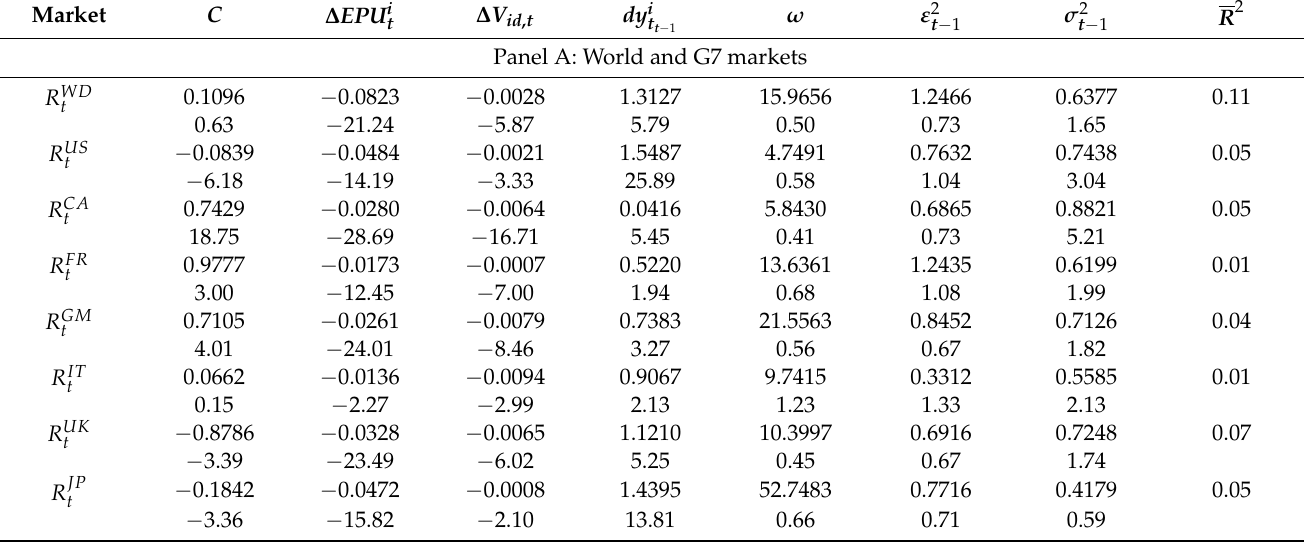
Table 4. Estimates of the global stock returns in response to change in economic policy uncertainty, change in infected decease uncertainty, and dividend yield using the GED–GARCH